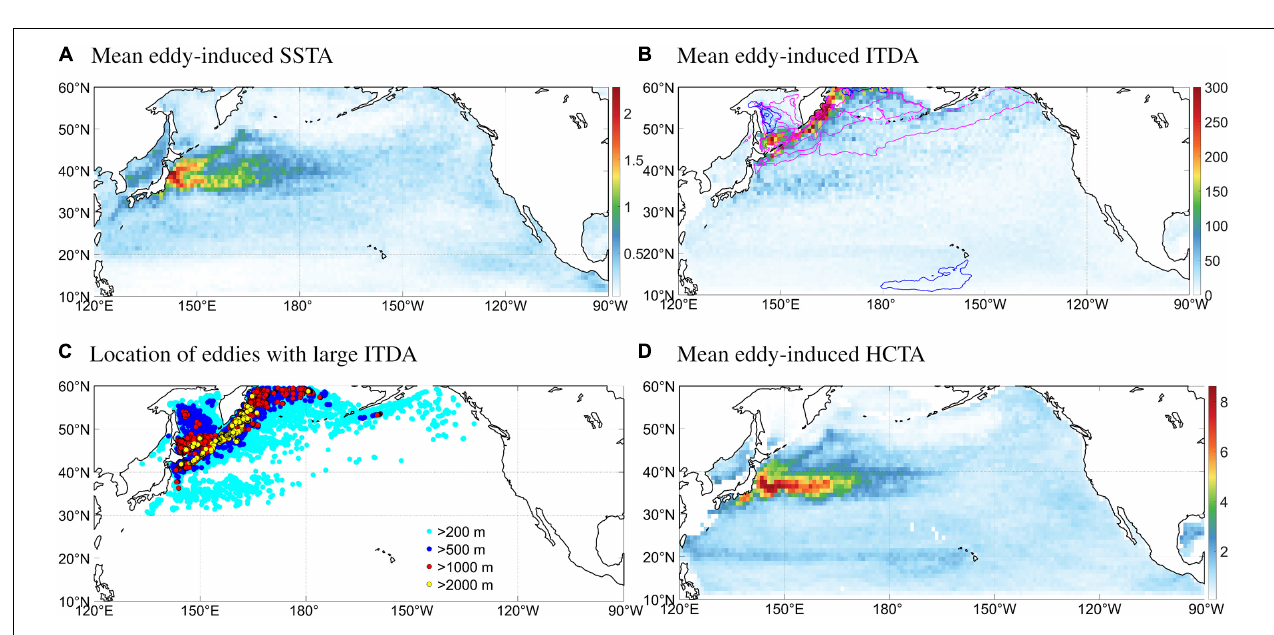
FIGURE 4 | Mean eddy-induced (A) SSTA ( ◦ C) (B) ITDA (m) averaged within 1 ◦ × 1 ◦ grid cells, organized by the instantaneous location of eddies. Shown are the absolute values averaged across cyclonic and anticyclonic eddies. In (B) , contours show the climatological mean ITD averaged across 1993–2019. Magenta contours are for winter (DJF) at 200, 500, 1,000, and 2,000 m levels, and blue contours are for summer (JJA) at 50, 100, and 150 m levels. (C) Location of eddies with | ITDA| > 200 m (cyan), 500 m (blue), 1,000 m (red), and 1,500 m (yellow). (D) Same as (A,B) but for HCTA (GJ/m 2 ).